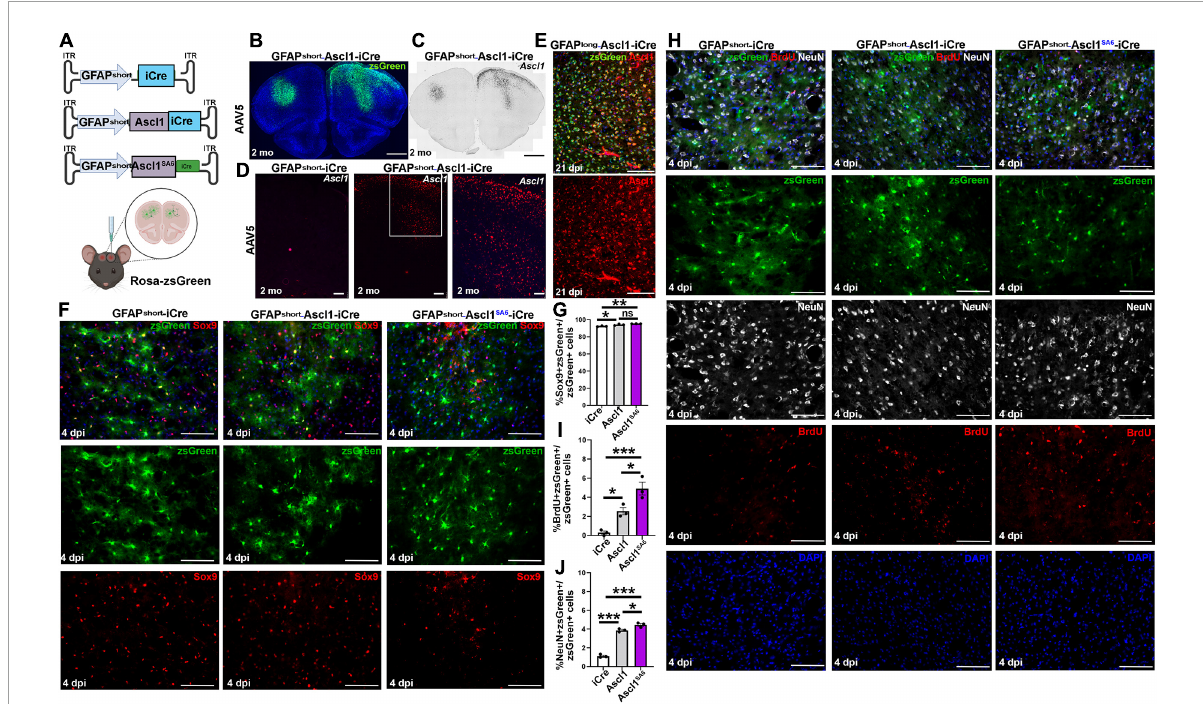
FIGURE3 Establishing a Cre-based lineage tracing system to follow the fate of cortical astrocytes transduced in vivo . (A) Schematic illustration of AAV5-GFAPshort-iCre vectors and injection strategy into the cortex in vivo . (B) zsGreen expression in the cortex of Rosa-zsGreen mice injected with AAV5-GFAPshort-Ascl1-iCre at 2-months post-transduction. Blue is DAPI counterstain. (C,D) Colorimetric RNA in situ hybridization (C) and fluorescent RNAscope analysis (D) of Ascl1 transcript distribution in cortices transduced with AAV5-GFAPshort-iCre (D) or AAV5-GFAPshort-Ascl1-iCre (C,D) at 2-months post-transduction. The boxed area in D is magnified in the panel to the right. (E) Ascl1 immunostaining of motor cortex of Rosa-zsGreen animal transduced with AAV5-GFAPlong-Ascl1-iCre and harvested 21 dpi. (F,G) Rosa-zsGreen cortex transduced with AAV5-GFAPshort-iCre, AAV5-GFAPshort-Ascl1-t2a-iCre, and AAV5-GFAPshort-Ascl1 SA 6 -t2a-iCre at 4 dpi, showing zsGreen epifluorescence and Sox9 expression (F) . Quantification of the percentage of zsGreen + cells that co-express GFAP (G) . (H–J) Rosa-zsGreen cortex transduced with AAV5-GFAPshort-iCre, AAV5-GFAPshort-Ascl1-t2a-iCre, and AAV5-GFAPshort-Ascl1 SA 6 -t2a-iCre at 4 dpi, showing zsGreen epifluorescence, NeuN (white), and Brdu (red) expression (H) . Blue is DAPI counterstain. Quantification of the percentage of zsGreen + cells that co-express BrdU (I) and NeuN (J) . Scale bars in panels B,C = 200 µ m, in panel D = 75 µ m, and in panels E,F,H = 100 µ m. Significance was defined as p -values less than 0.05 and denoted as follows: ns, not significant, < 0.05 *, < 0.01 **, < 0.001